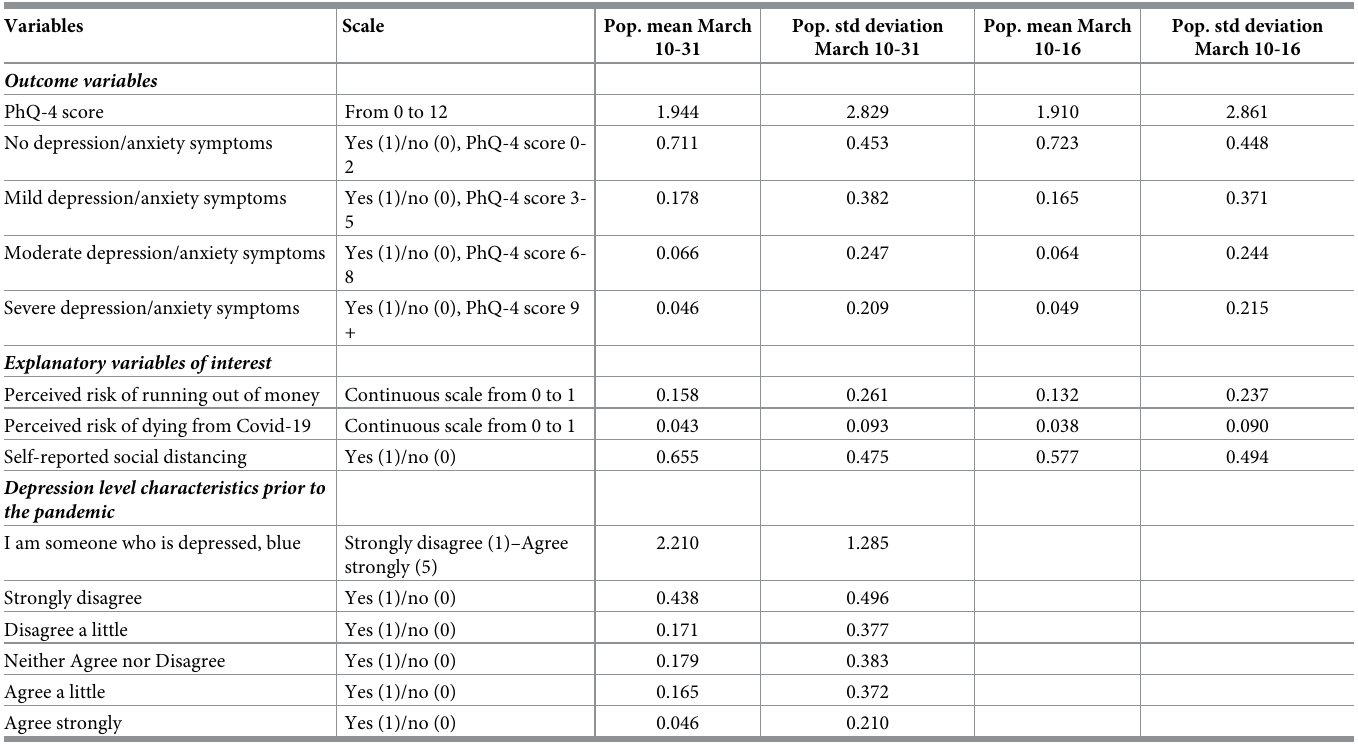
Table 1. Summary statistics ( N = 6, 585).